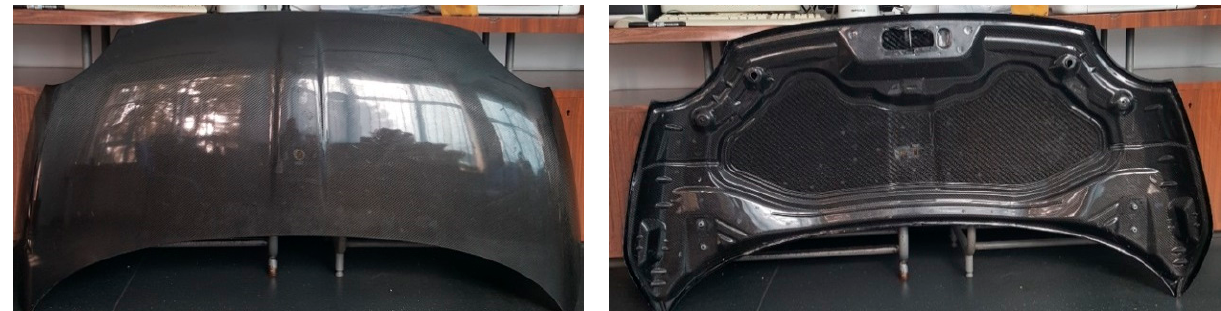
Figure 8. The obtained CFRP front hood “A” made according to the BMD concept.